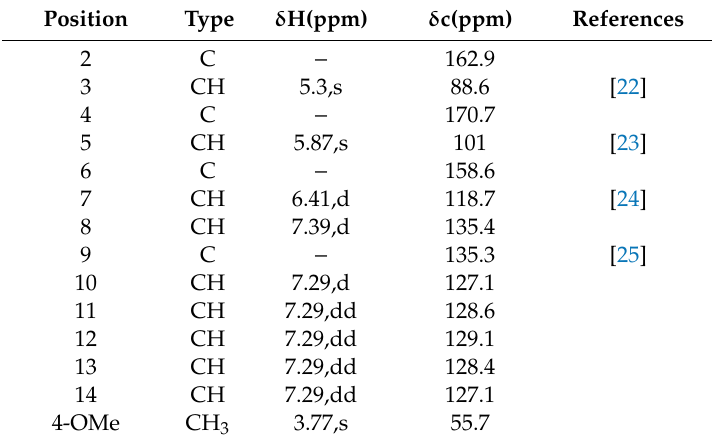
Figure 1. Chemical structure of 5,6-dehydrokawain (DK). Table 3. 1 H and 13 C-NMR data using CDCl 3 solvent.